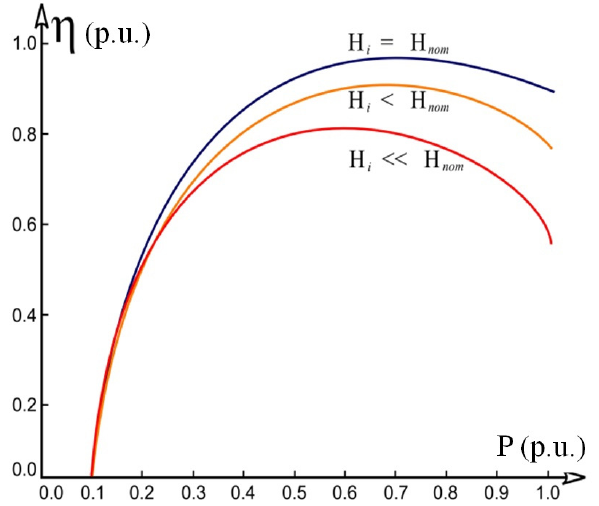
Figure 1. HPP units’ efficiency at different water heads.